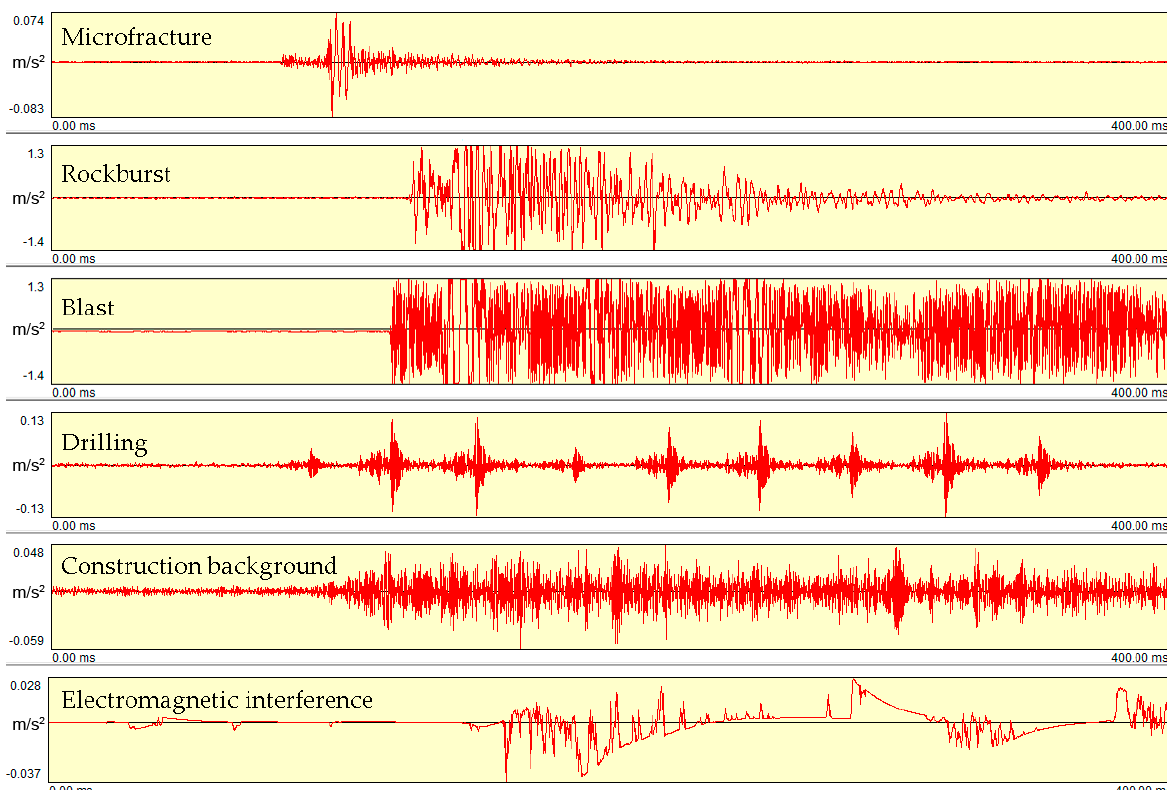
Figure 3. Typical signals received from different sources.